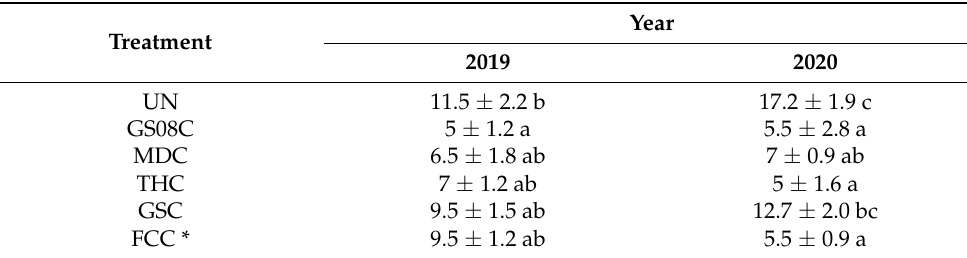
Table 3. Density of Sitona lineatus (weevil m − 2 ) at BBCH 16 in broad bean treated at different times with insecticide.